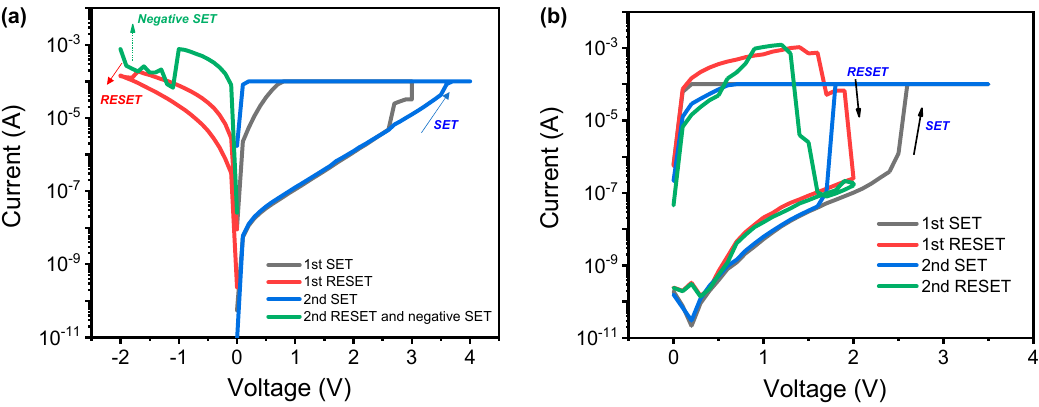
Figure 2. ( a ) Current–voltage (I–V) curves including SET, RESET, and negative-SET of Ag / ZrN / Si device for bipolar resistive switching; ( b ) I–V curves of Ag / ZrN / Si device for unipolar resistive switching.